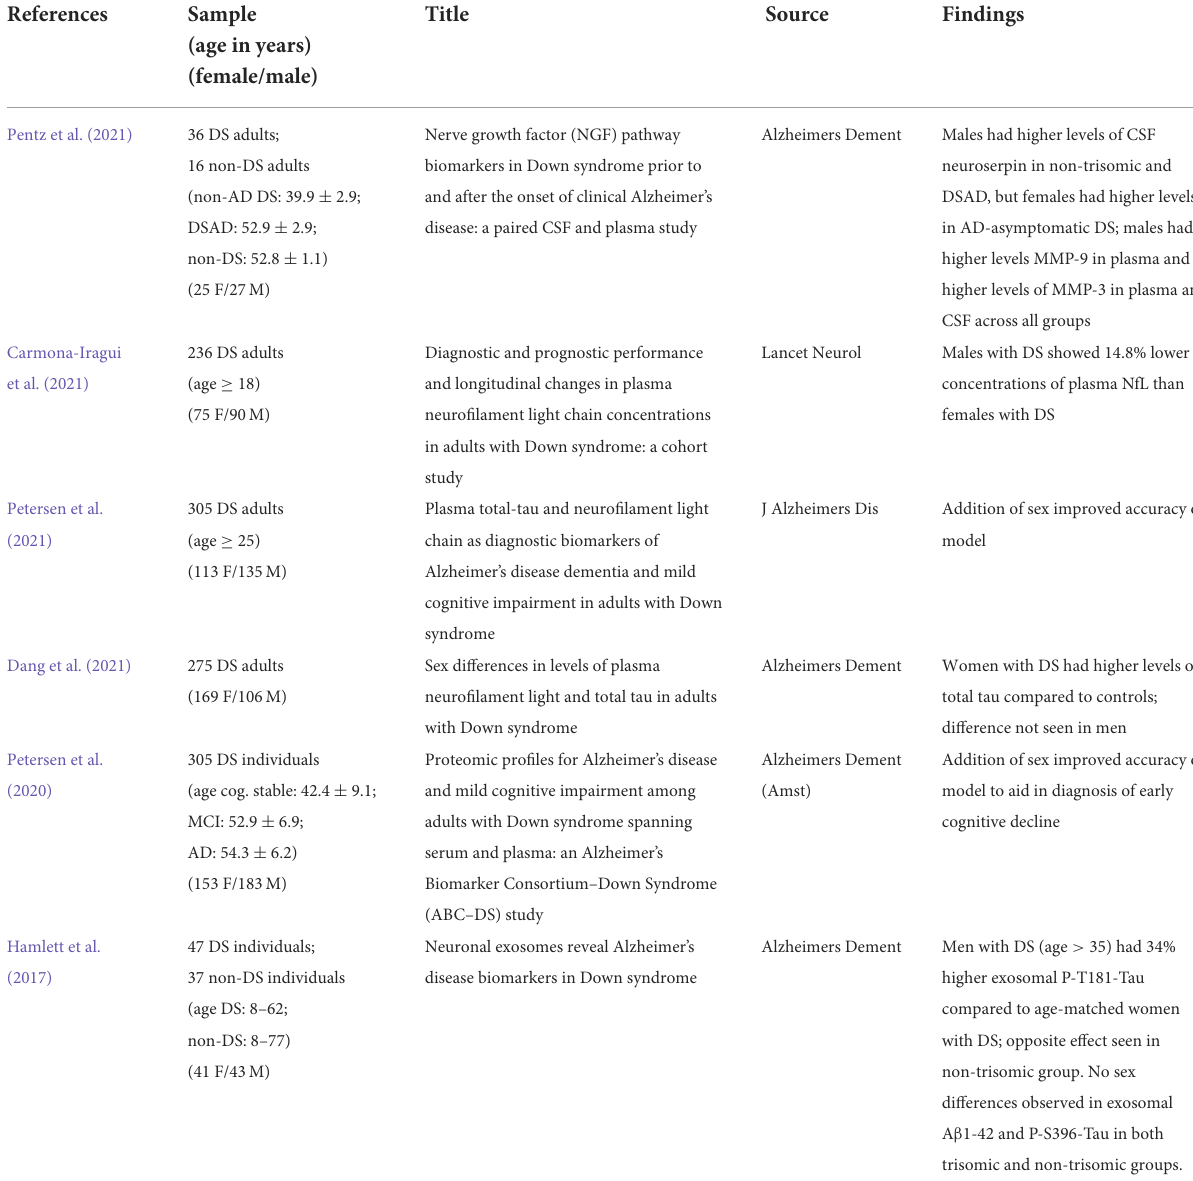
TABLE 3 Literature on sex differences in Alzheimer’s disease biomarkers in Down